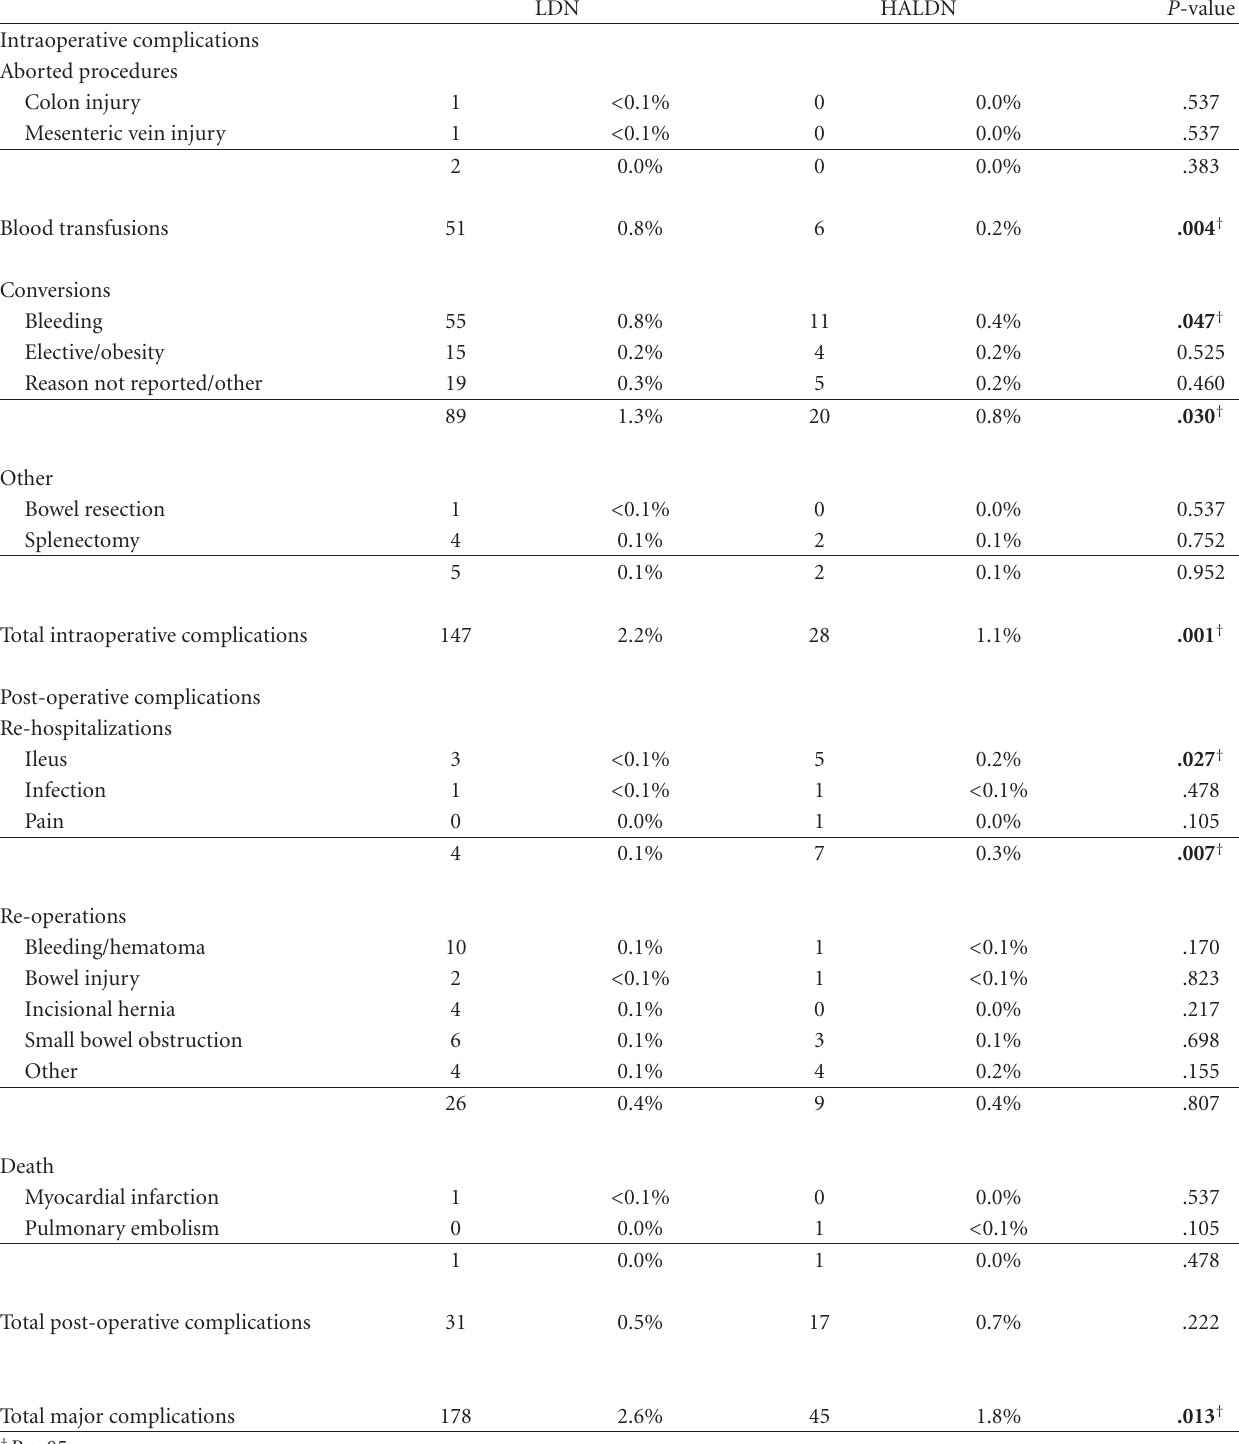
Table 4: Major intraoperative and postoperative complications of LDN and HALDN. LDN HALDN P